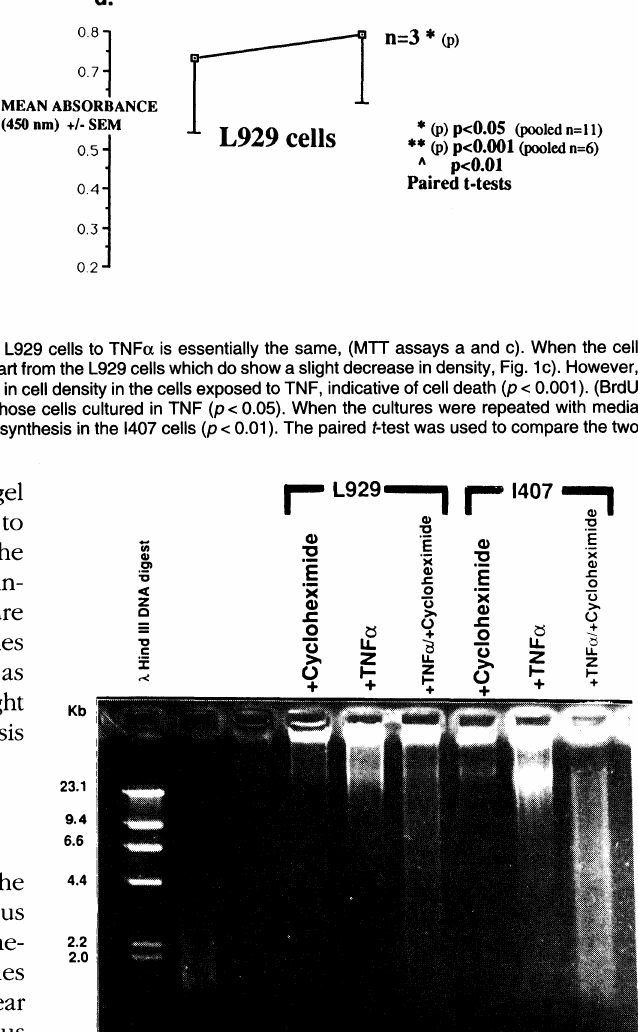
FIG. 4. Agarose gel showing fragmented DNA of 1407 and L929 cells after 16 h exposure to TNF and/or cycloheximide. Undamaged high molecular weight DNA remains close to, or in, the anode well. Fragmented DNA of a variety of smaller molecular weights are apparent as smears down the electrophoresis